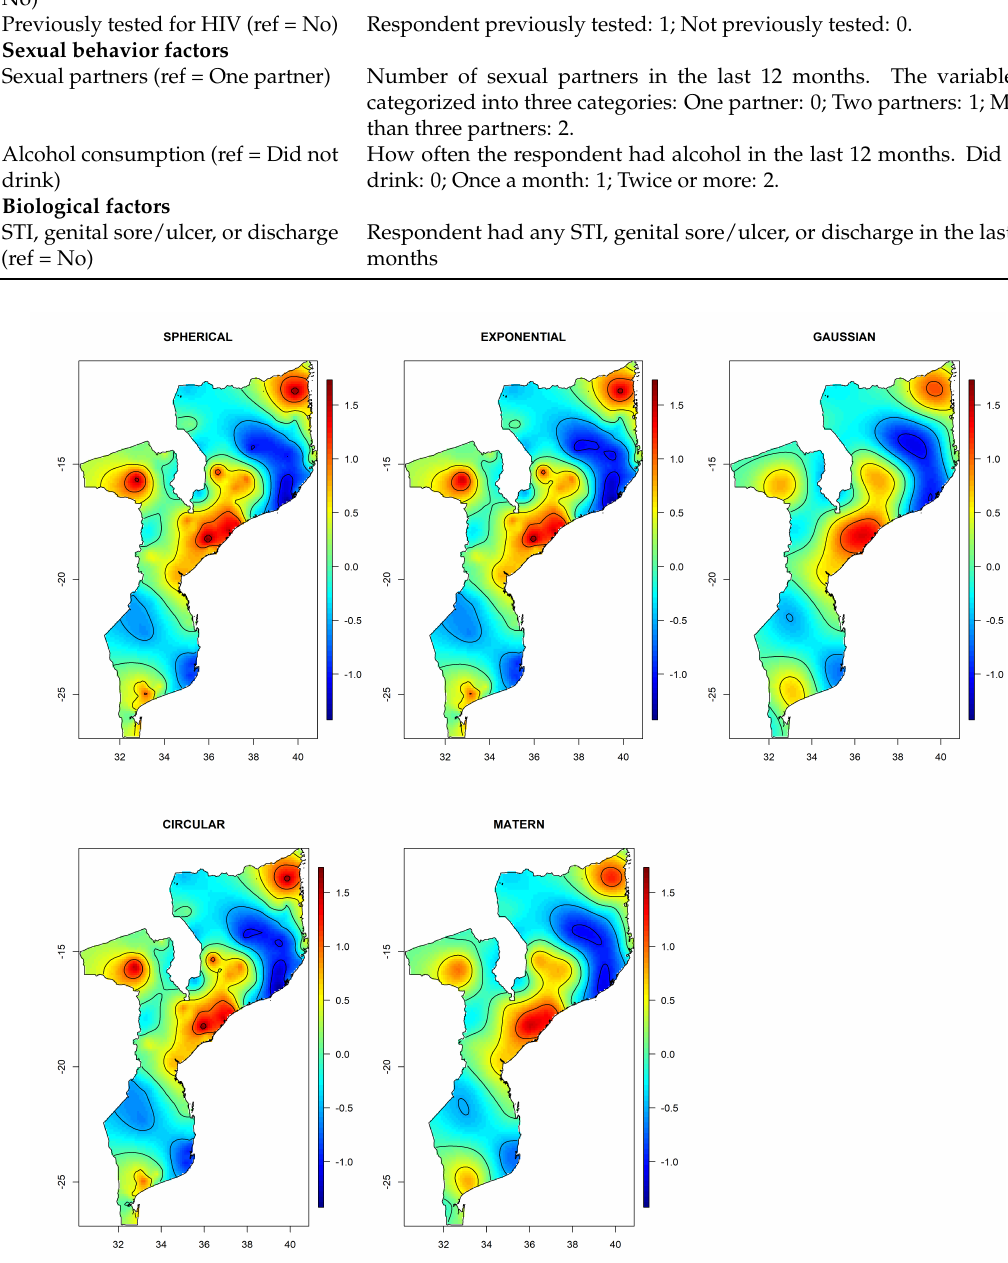
Figure A1. Image plots of the radial spline basis under different covariance functions. The images correspond to the model with only the spatial component . Model is fitted using two-stage iterative estimation process. The radial spline basis is plotted on natural log-odds scale. This illustrates the spatial variation of HIV risk in